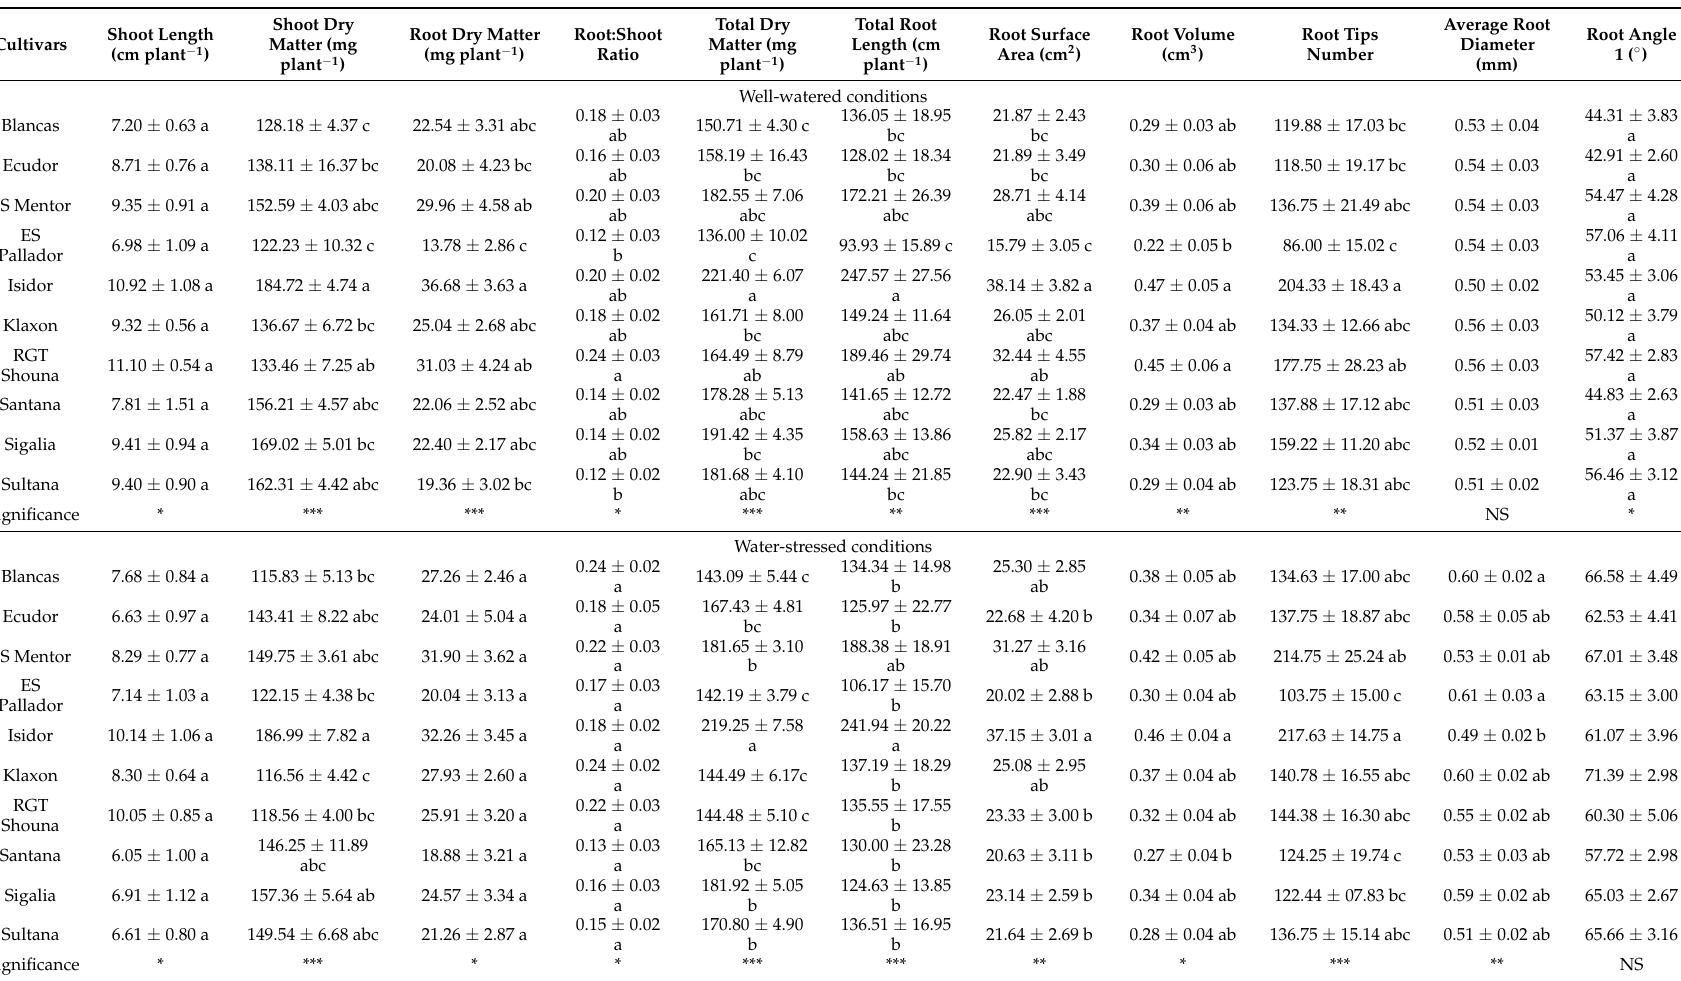
Table 2. A comparison of shoot and root morpho-physiological and root architectural traits in ten soybean cultivars under well-watered and water-stressed conditions.